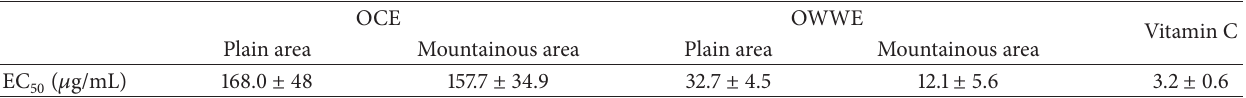
Table 4: Scavenging effects (EC 50 𝜇 g/mL) of OCE and OWWE on DPPH free